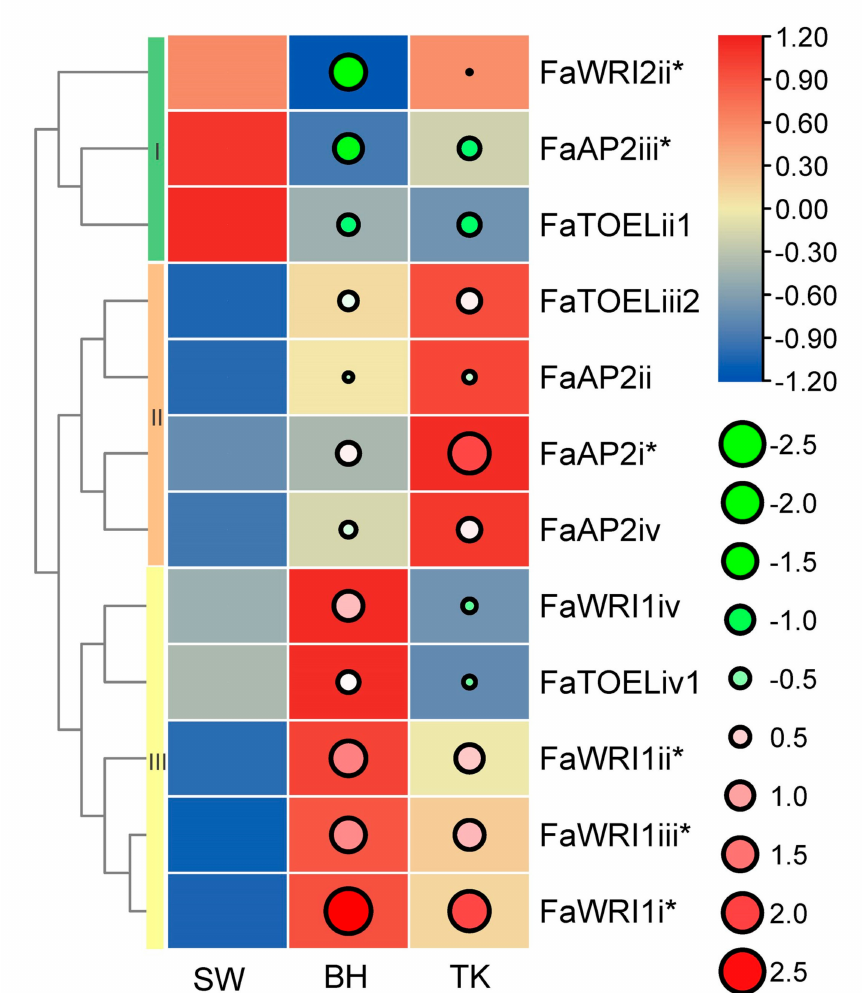
Figure 4. Expression profile of AP2 genes in three strawberry cultivars. AP2 genes are listed in rows, and the ‘Benihoppe,’ ‘Tokun,’ and ‘Snow White’ cultivars (SW, BH, and TK, respectively) are listed in columns. Normalized TPM (transcripts per kilobase of exon model per million mapped reads) are indicated by the gradient color of rectangles, and three row clusters are indicated by I, II, and III. Log2(fold-change) values using SW as a control sample are indicated by circle size and gradient color. * indicates significantly differentially expressed